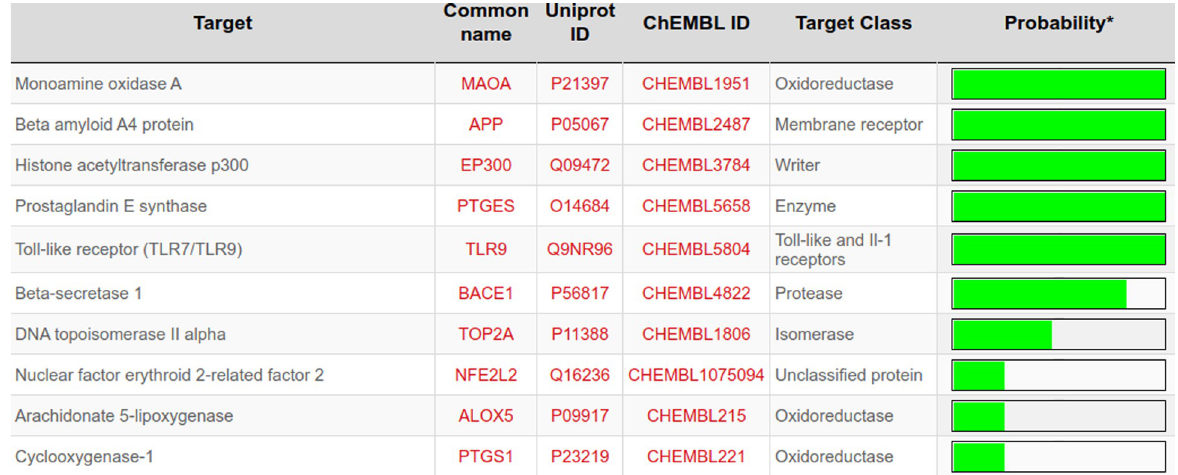
Fig 11. Names and target probabilities of top 10 predicted molecular targets of curcumin obtained from Swiss TargetPrediction.